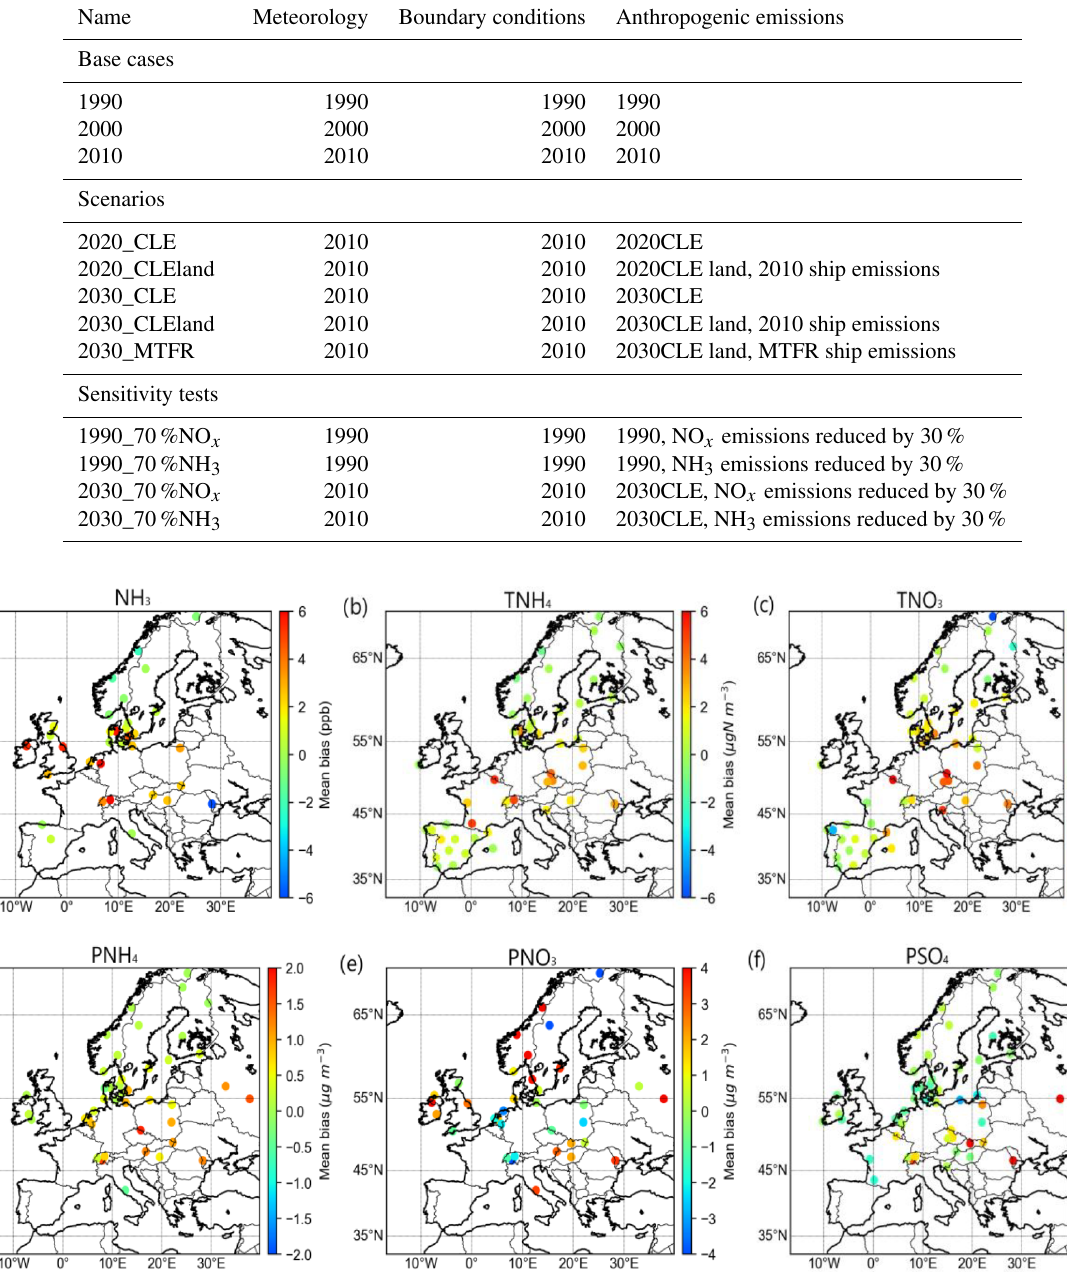
Figure 1. Mean bias between measured and modeled concentrations of (a) ammonia (ppb), (b) total ammonium (µgNm − 3 ), (c) total nitrate (µgNm − 3 ), (d) ammonium (µgm − 3 ), (e) particulate nitrate (µgm − 3 ) and (f) sulfate (µgm − 3 ) at various sites in